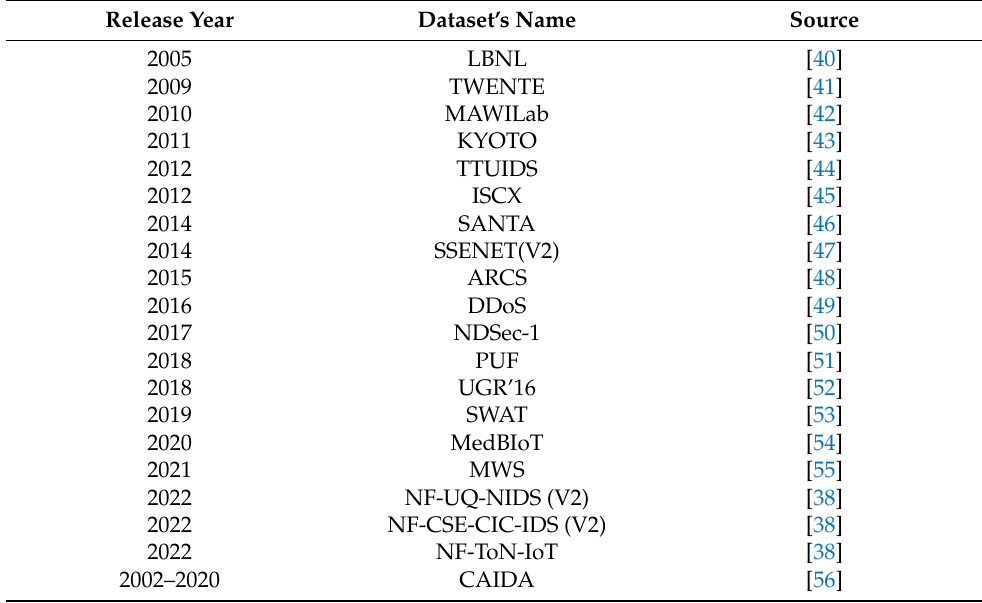
Table 4. Additional datasets for cybersecurity